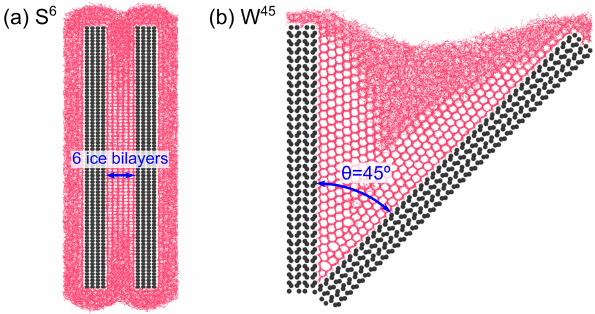
Figure 1. Simulation models of the (a) slit system with a gap width accommodating six ice bilayers ( S 6 ) and (b) wedge system with an- gle θ = 45 ◦ ( W 45 ). AgI surface atoms are shown as black spheres, and the hydrogen bond network between water molecules is shown as red